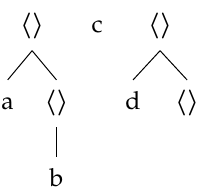
Figure 1. Nested word